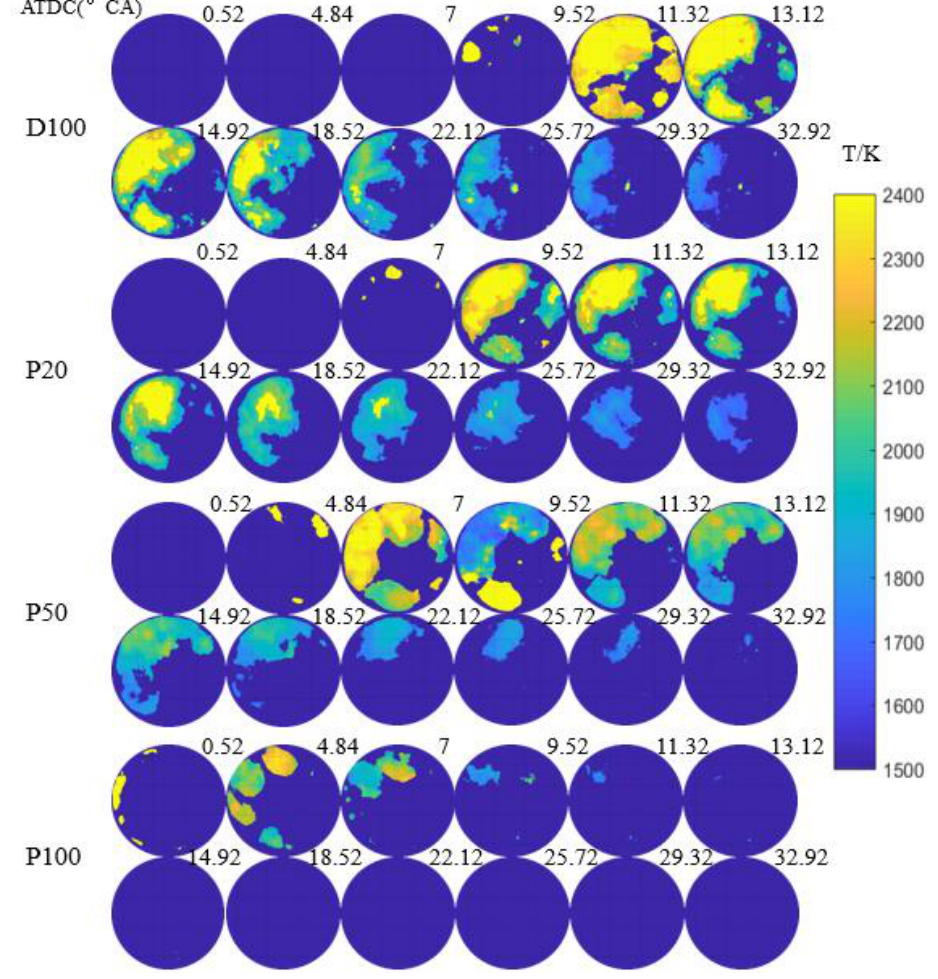
Figure 5. Spatial temperature distribution (Injection pressure: 100 MPa; Injection timing: 6 °CA BTDC).